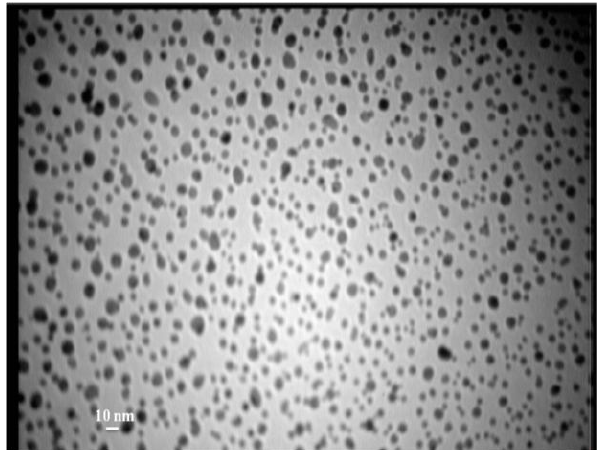
Fig. 3. TEM image of arc fabricated silver nanopowder